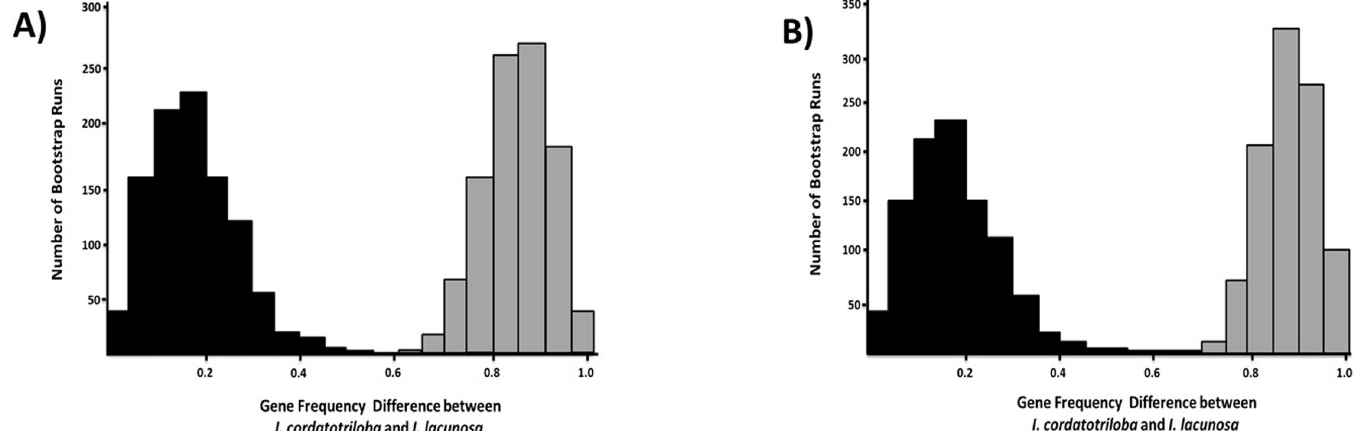
Fig 5. Bootstrapped between-species allele-frequency differences for microsatellite loci and Anl1 . A) Analysis method 1. B) Analysis method 2. Black bars: Average allele frequency difference across microsatellite loci. Grey bars: Average allele frequency difference at Anl1 .